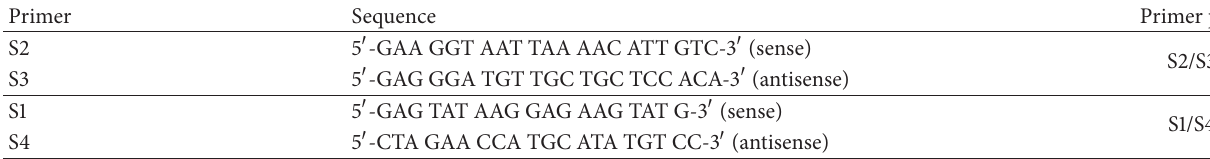
Table 1: Sequence of primers for amplifying msp2 gene of Plasmodium falciparum .